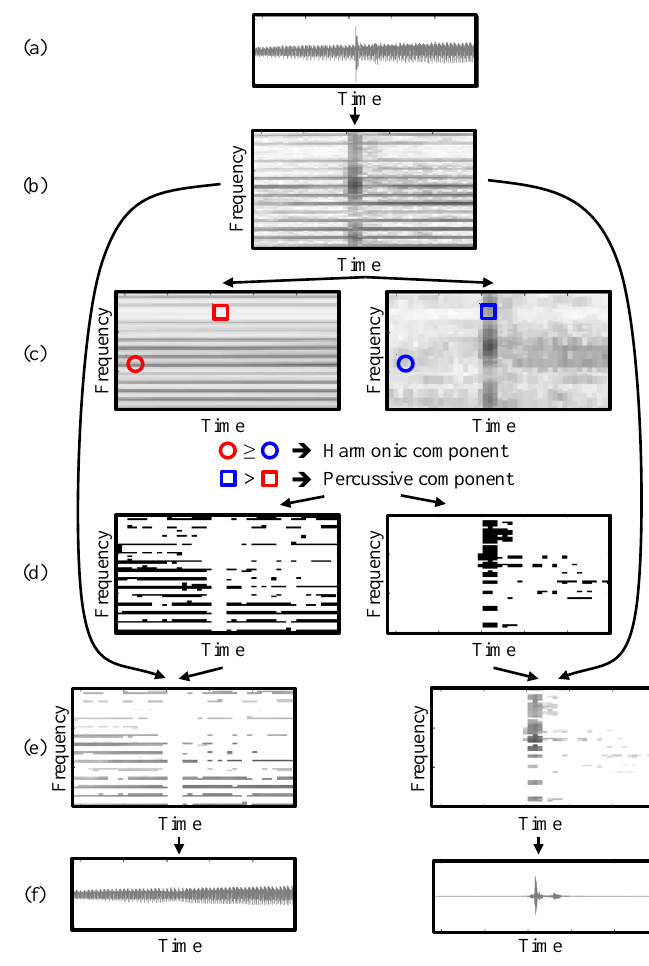
Figure 13. The HPS procedure presented in [23]. ( a ) Input audio signal x ; ( b ) STFT X of x ; ( c ) Horizontally and vertically enhanced spectrograms ˜ Y h and ˜ Y p ; ( d ) Binary masks M h and M p ; ( e ) Spectrograms of the harmonic and the percussive component X h and X p ; ( f ) Harmonic and percussive components x h and x p